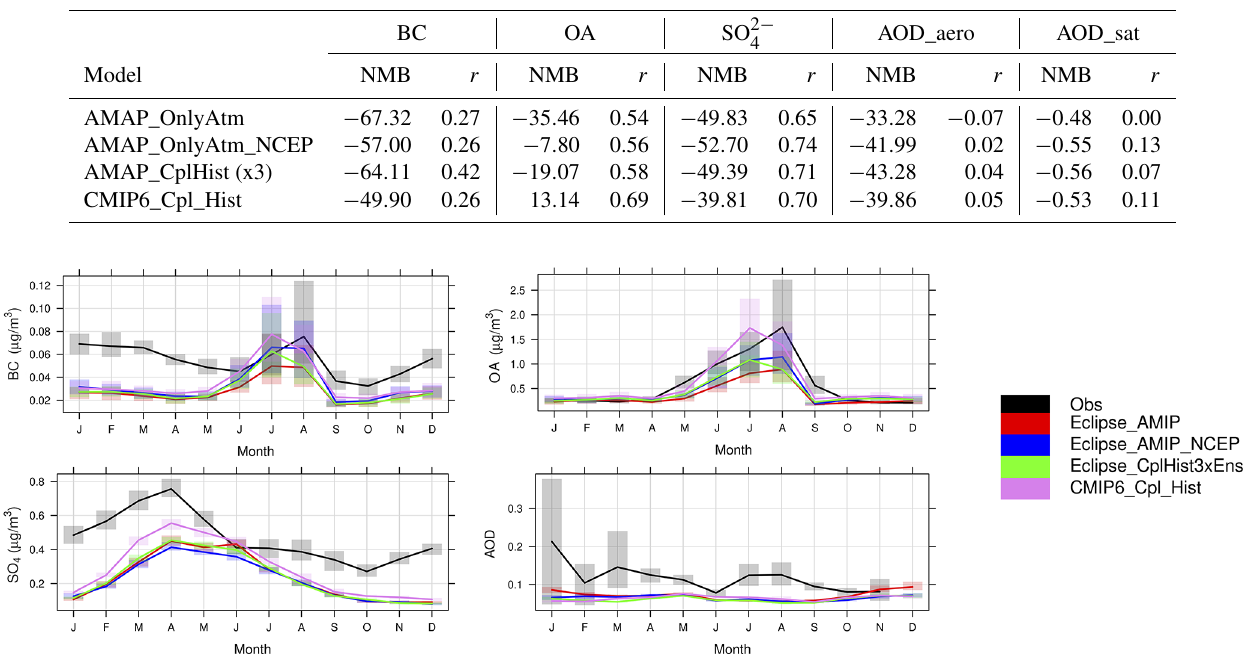
Figure 2. Observed and simulated Arctic climatological (1995–2014) monthly BC, OA, SO 2 − 2014), along with the interannual variation shown in bars. The data present monthly accumulated time series for all stations that are merged